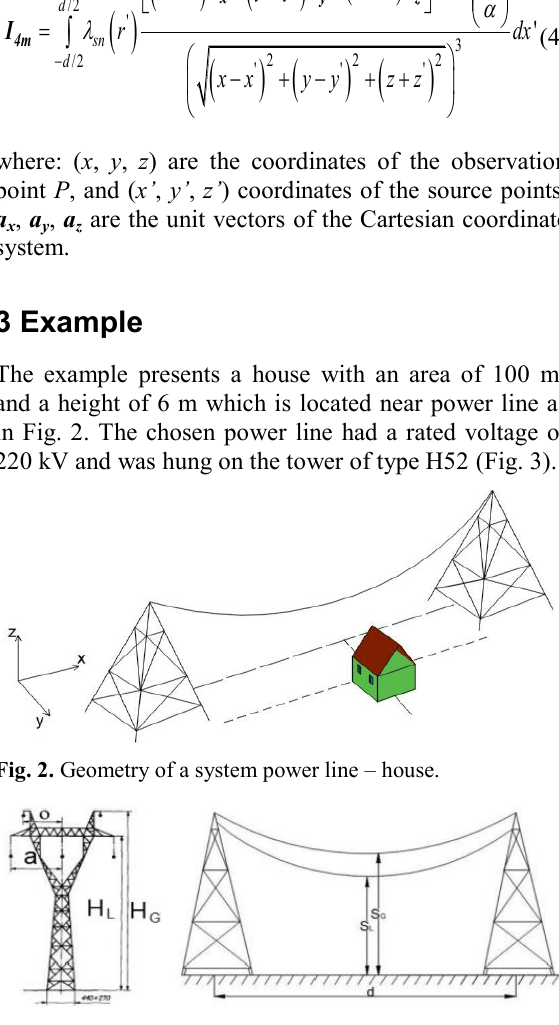
Fig. 3. Parameters of the 220 kV line.